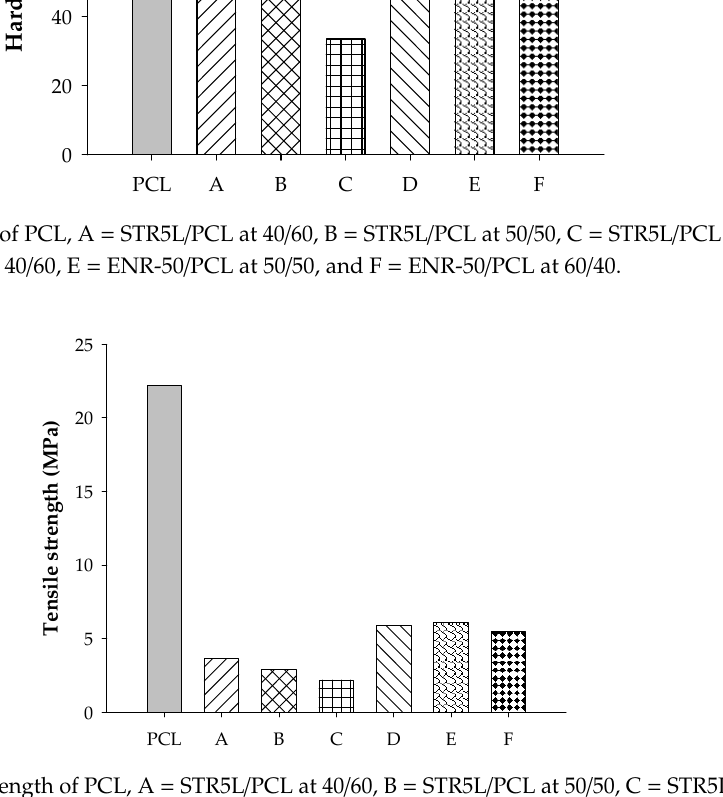
Figure 6. Tensile strength of PCL, A = STR5L / PCL at 40 / 60, B = STR5L / PCL at 50 / 50, C = STR5L / PCL at 60 / 40, ENR-50 / PCL at 40 / 60, E = ENR-50 / PCL at 50 / 50, and F = ENR-50 / PCL at 60 / 40.